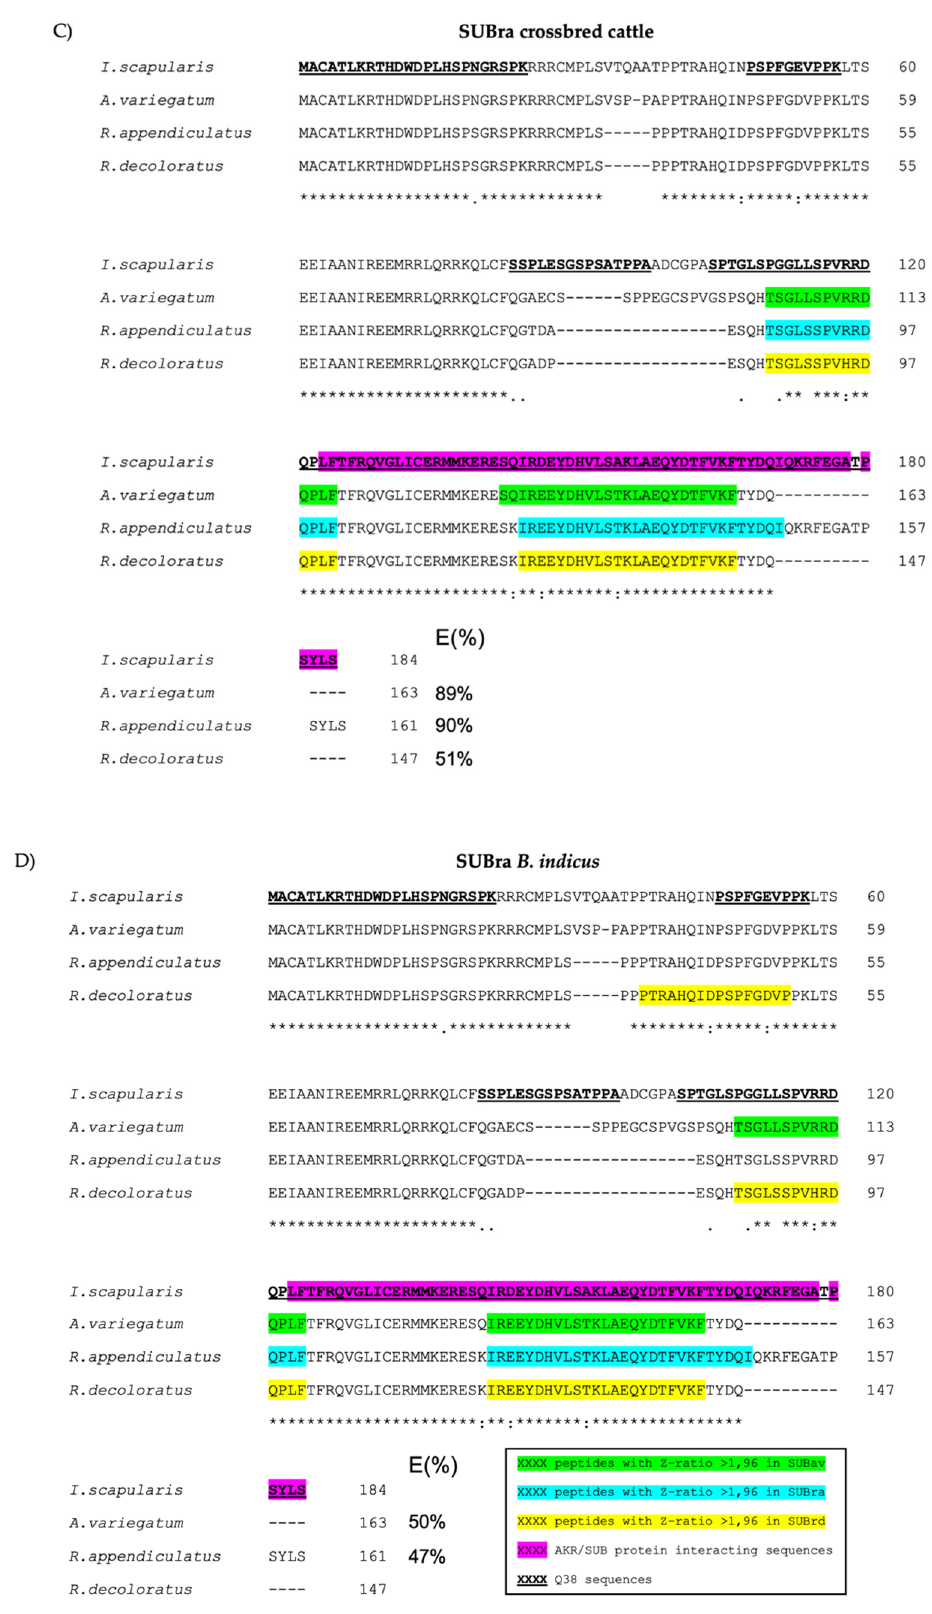
Figure 3. Alignment of SUB amino acid protein sequences from I. scapularis , R. appendiculatus , R. decoloratus , and A. variegatum . Reactive epitopes identified in the immunized groups ( A ) cocktail SUB in crossbred cattle, ( B ) cocktail SUB in B. indicus , ( C ) SUBra in crossbred cattle, and ( D )